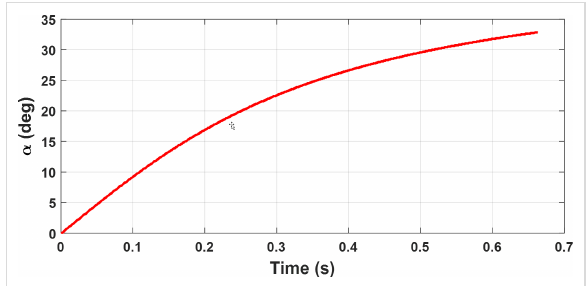
Figure 6: Simulations of the variation of the tip force angle ( α ) during the manipulation process until achieving the critical time for the sliding mode.